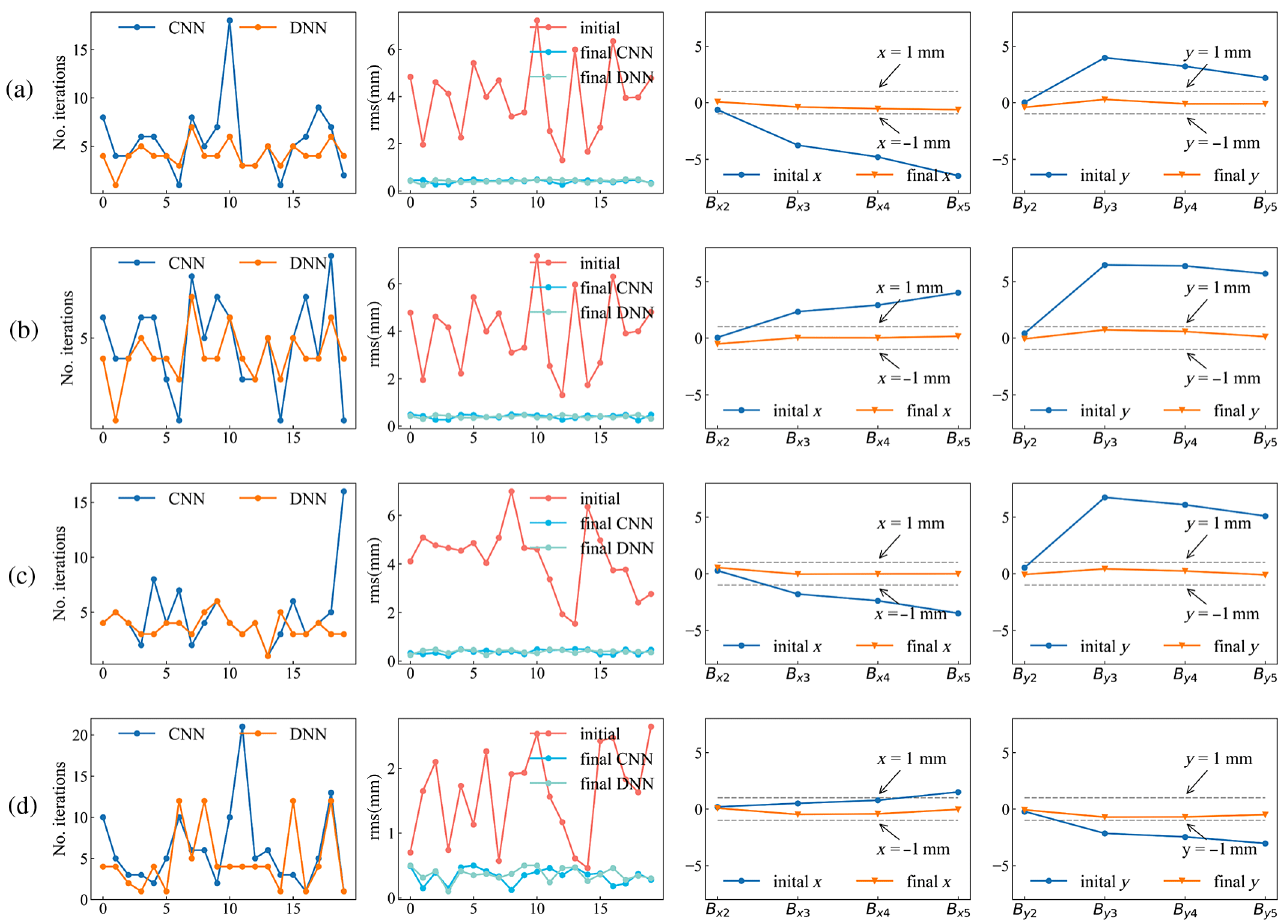
FIG. 6. 20 sets of experiments were performed for the two agents, using the same rms value as the initial setting for each experiment in every set. In this chart, CNN represents the agent based on physical prior knowledge, and DNN represents the agent with the original network structure of TD3. (a) Use the agents trained with 40 Ca 13 þ to correct the orbit of itself. (b) Use the agents trained with 40 Ca 13 þ to correct the orbit of itself with additional (cid:2) 30% random error in the origin lattice. (c) Use the agents trained with 40 Ca 13 þ to correct the orbit of 55 Mn 18 þ . (d) Use the agents trained with 40 Ca 13 þ to correct the orbit of the